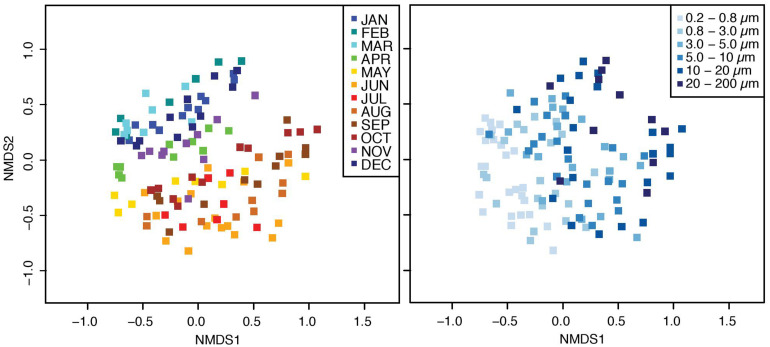
nMDS ordinations representing the Bray–Curtis distances between bacterial communities. Distances were calculated from the rarefied OTU table. Samples are color-coded depending on the month (left panel) and size-fraction (right panel).